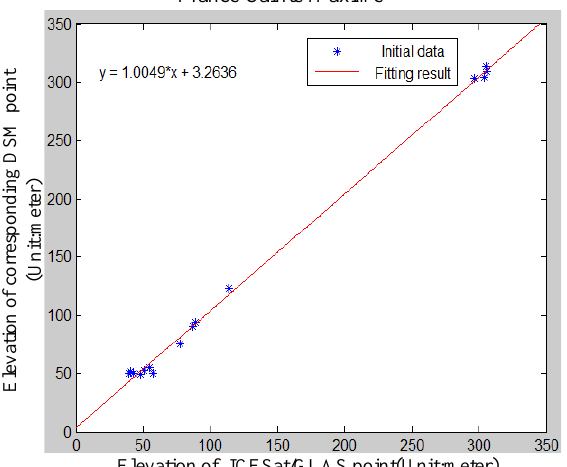
Figure 6. The illustration of GCPs and CPs distribution in France-Sainte Maxime